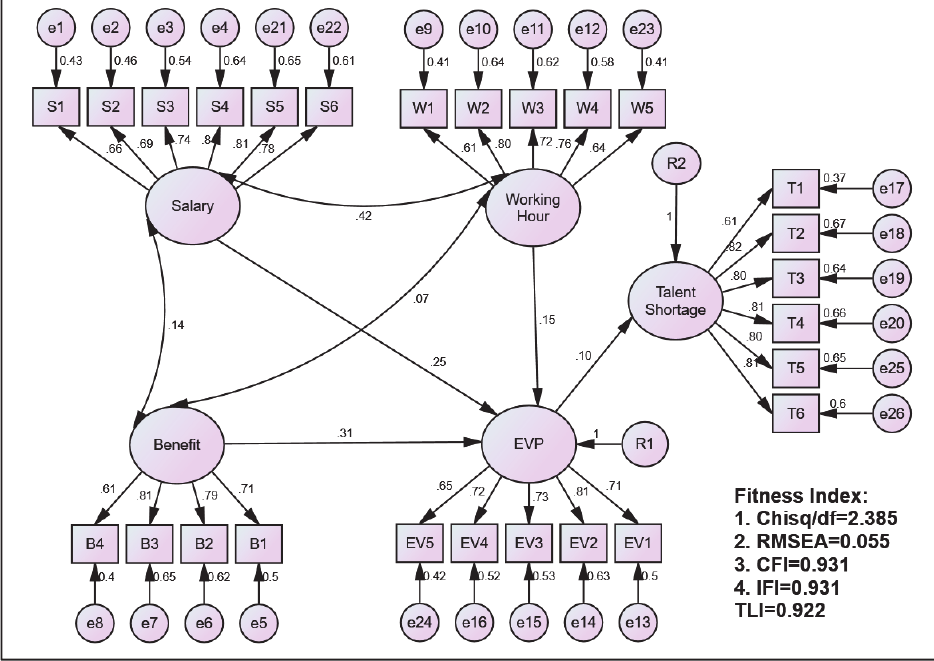
Fig. 3. Standardized Structural